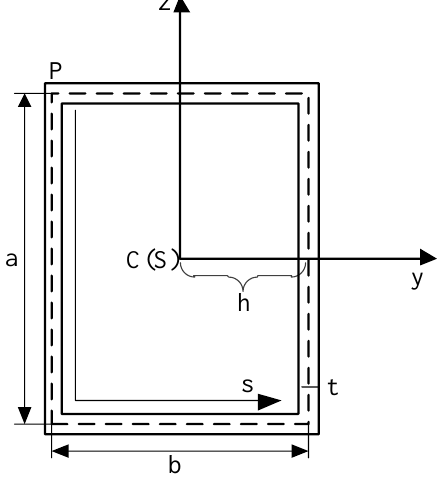
Figure 2. The details of the cross-section.